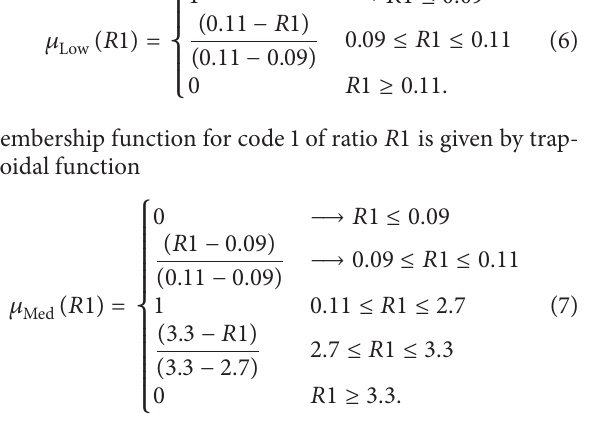
Figure 1: Flow chart of proposed system diagnosis.